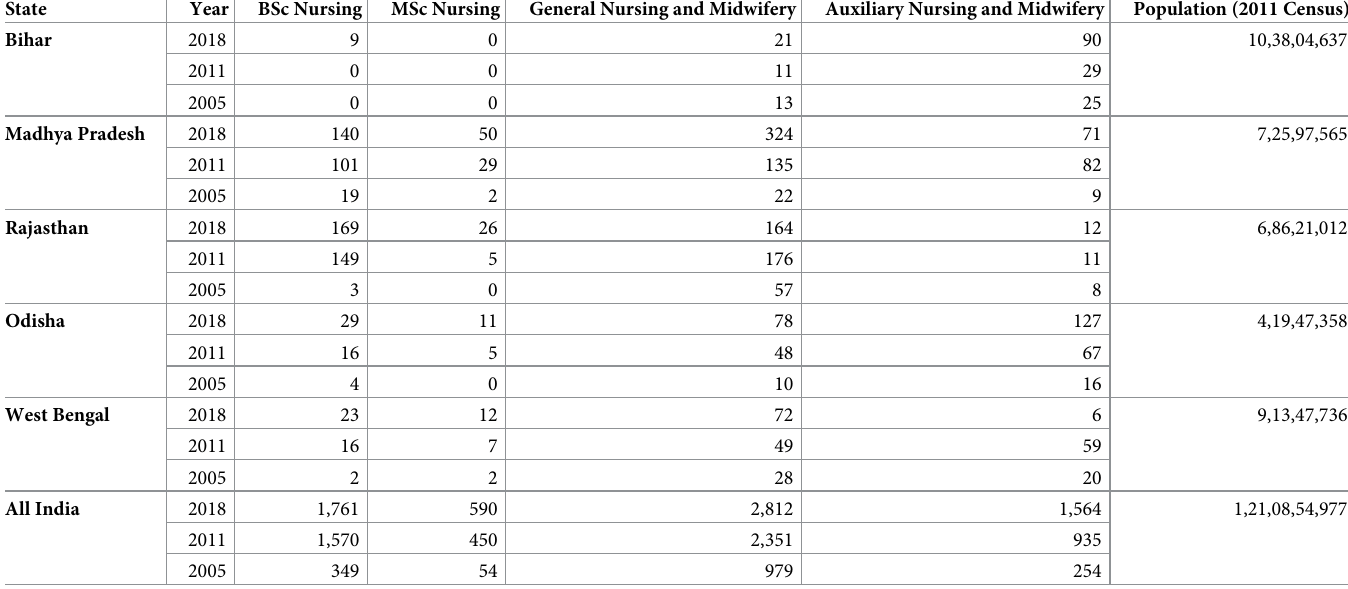
Table 3. Nursing and midwifery training institutions in selected states